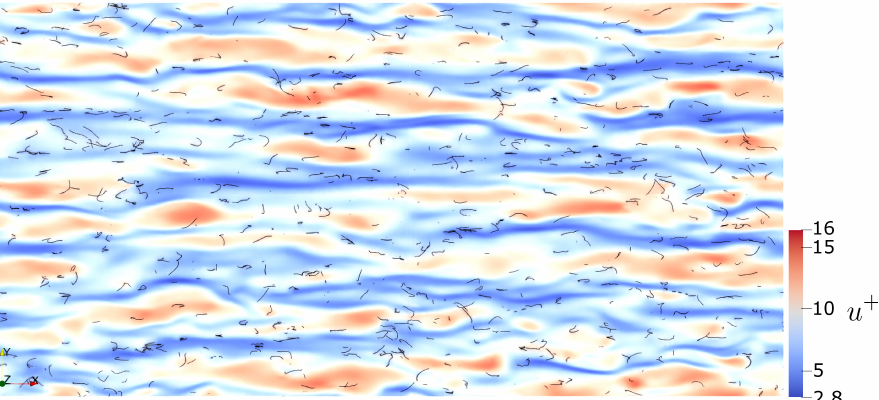
= 1.3, φ = 2.12 · 10 − 5 . ρ